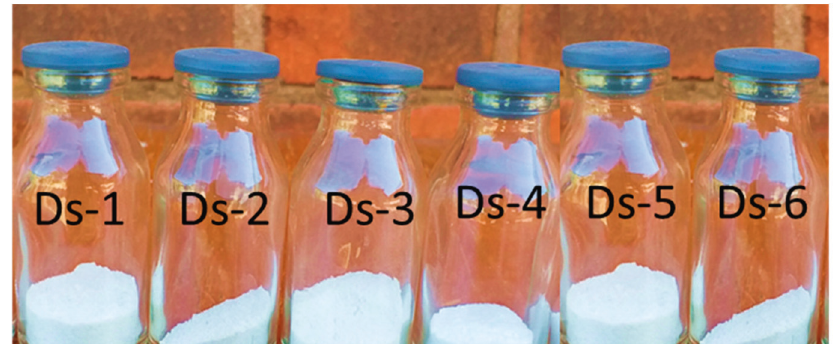
Figure 2: Prepared powder natural opal samples for